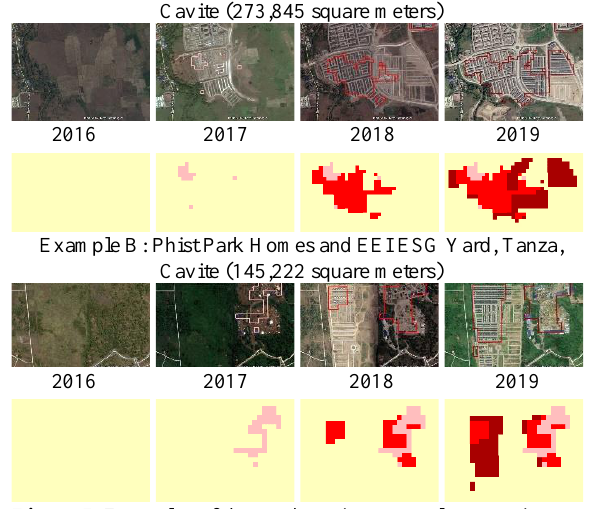
Figure 5. Examples of detected spatio-temporal conversions. Colors of polygons refer to timeframe of conversion – 2016 to 2017 (pink); 2017 to 2018 (red); 2018 to 2019 (maroon)